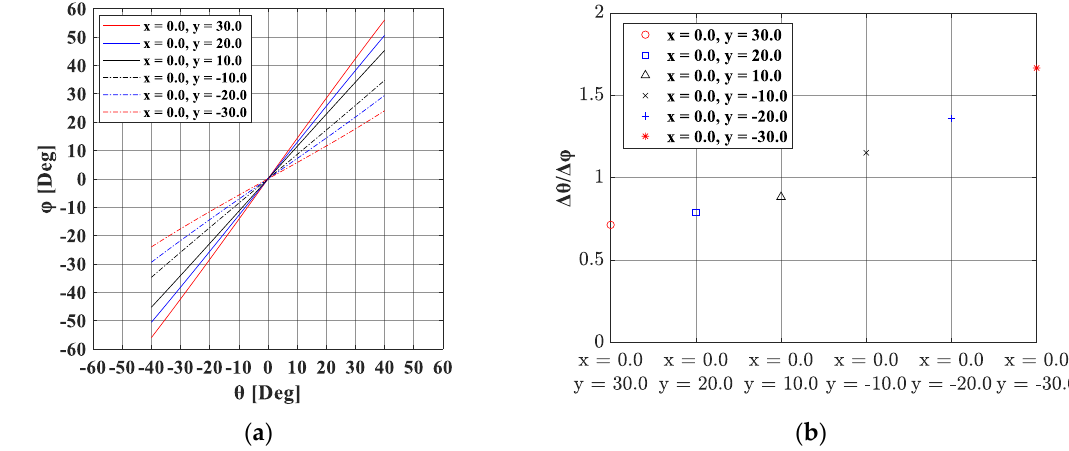
Figure 14. ( a ) Relationship of θ and φ with the y offset; ( b ) c omparison of θ and φ with the y offset.